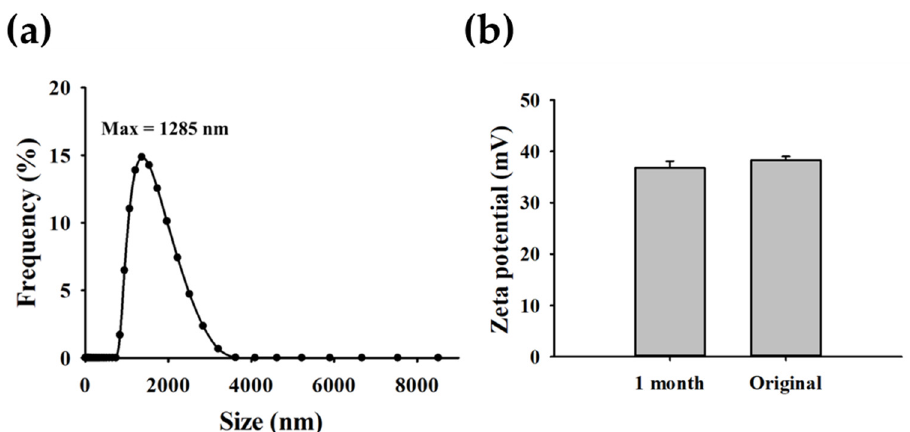
Figure 4. Measurement of the ( a ) zeta potential and ( b ) size of CuO NPs. The zeta potential of both original samples from the synthesis and 1 month after synthesis was measured. Data are shown as the mean ± SD ( n = 3; p < 0.05).